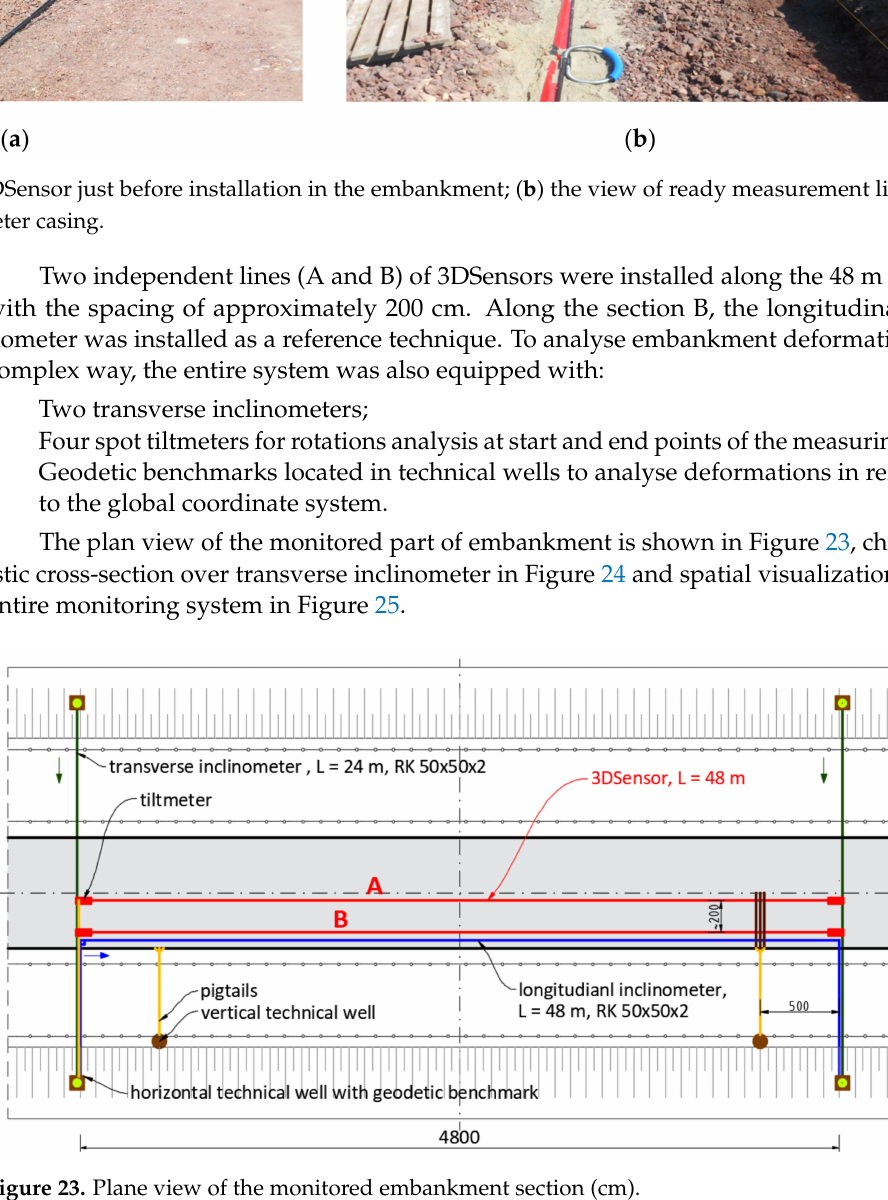
Figure 23. Plane view of the monitored embankment section